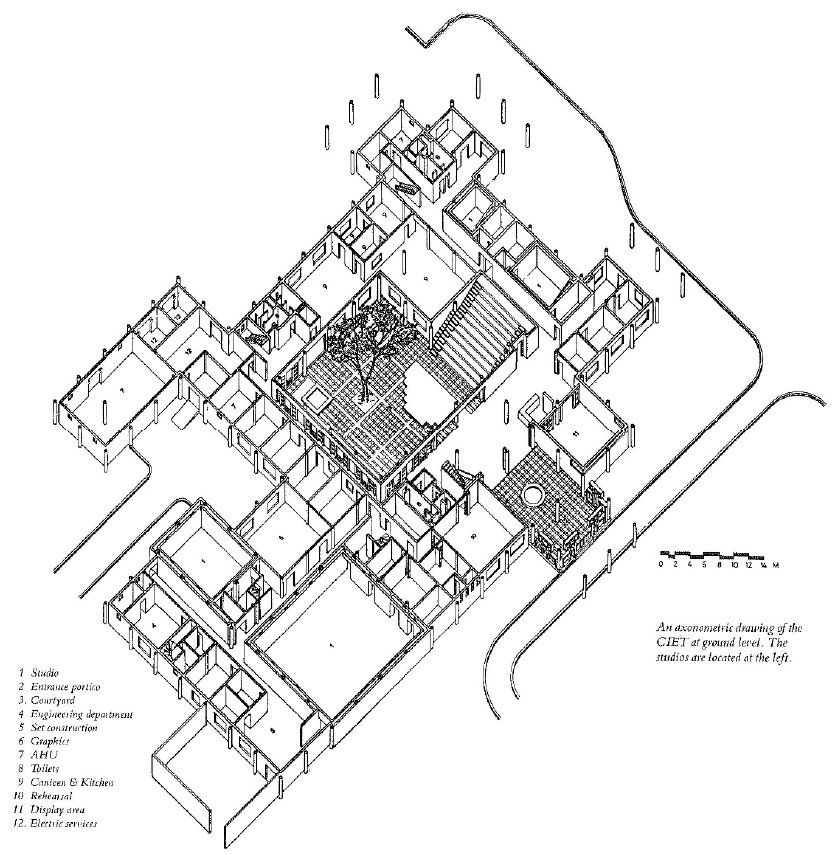
Figure 12. Central courtyard acts as a focal point in the CIET building (Courtesy: Raj Rewal Associates).